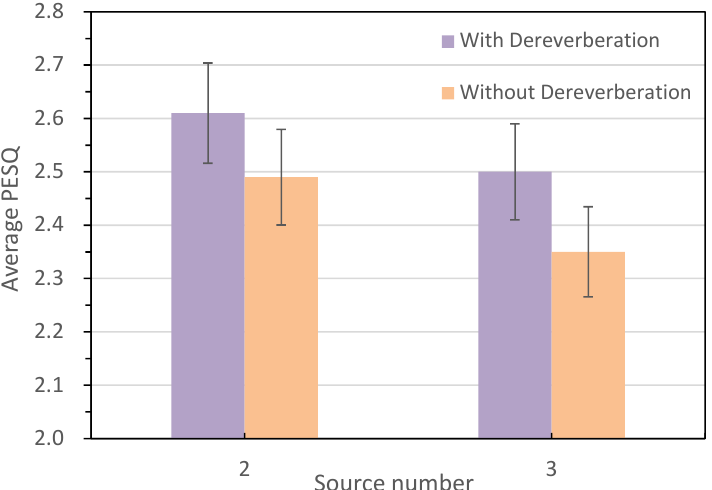
Figure 9. Average PESQ of signals separated by the proposed method with or without dereverberation.